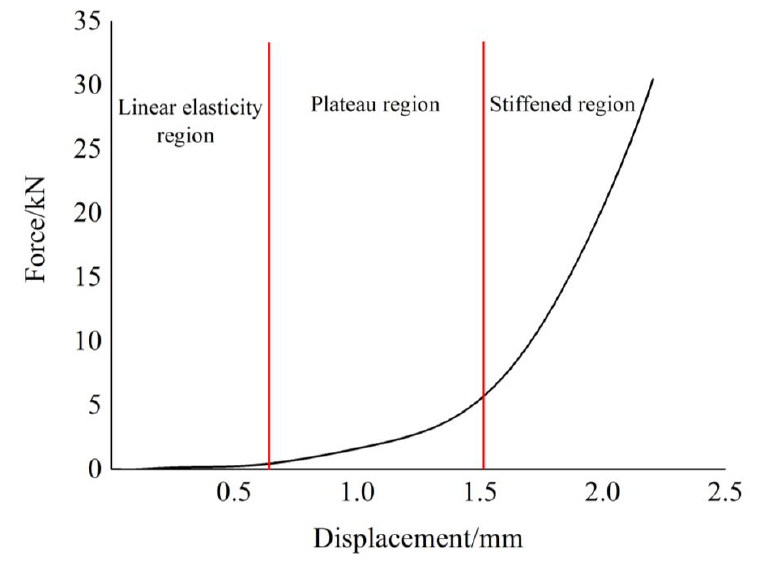
Figure 5. Sketch of the loading process of EMWM.